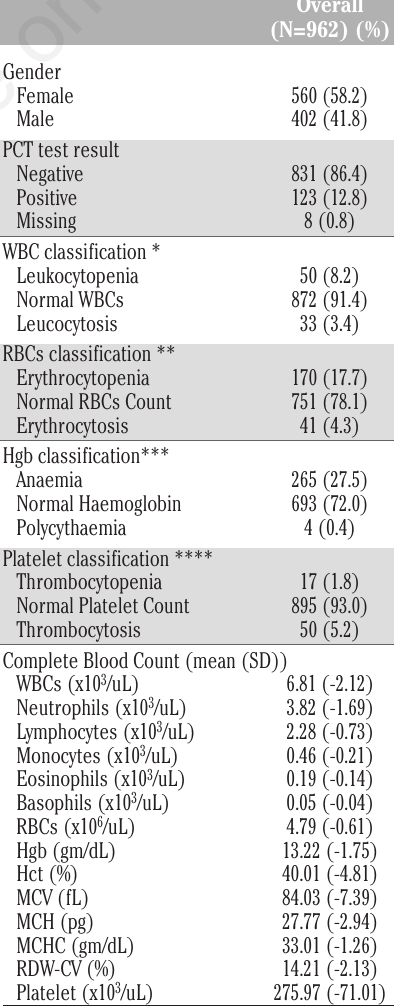
Table 1. Descriptive of haematological charac- teristics among the study